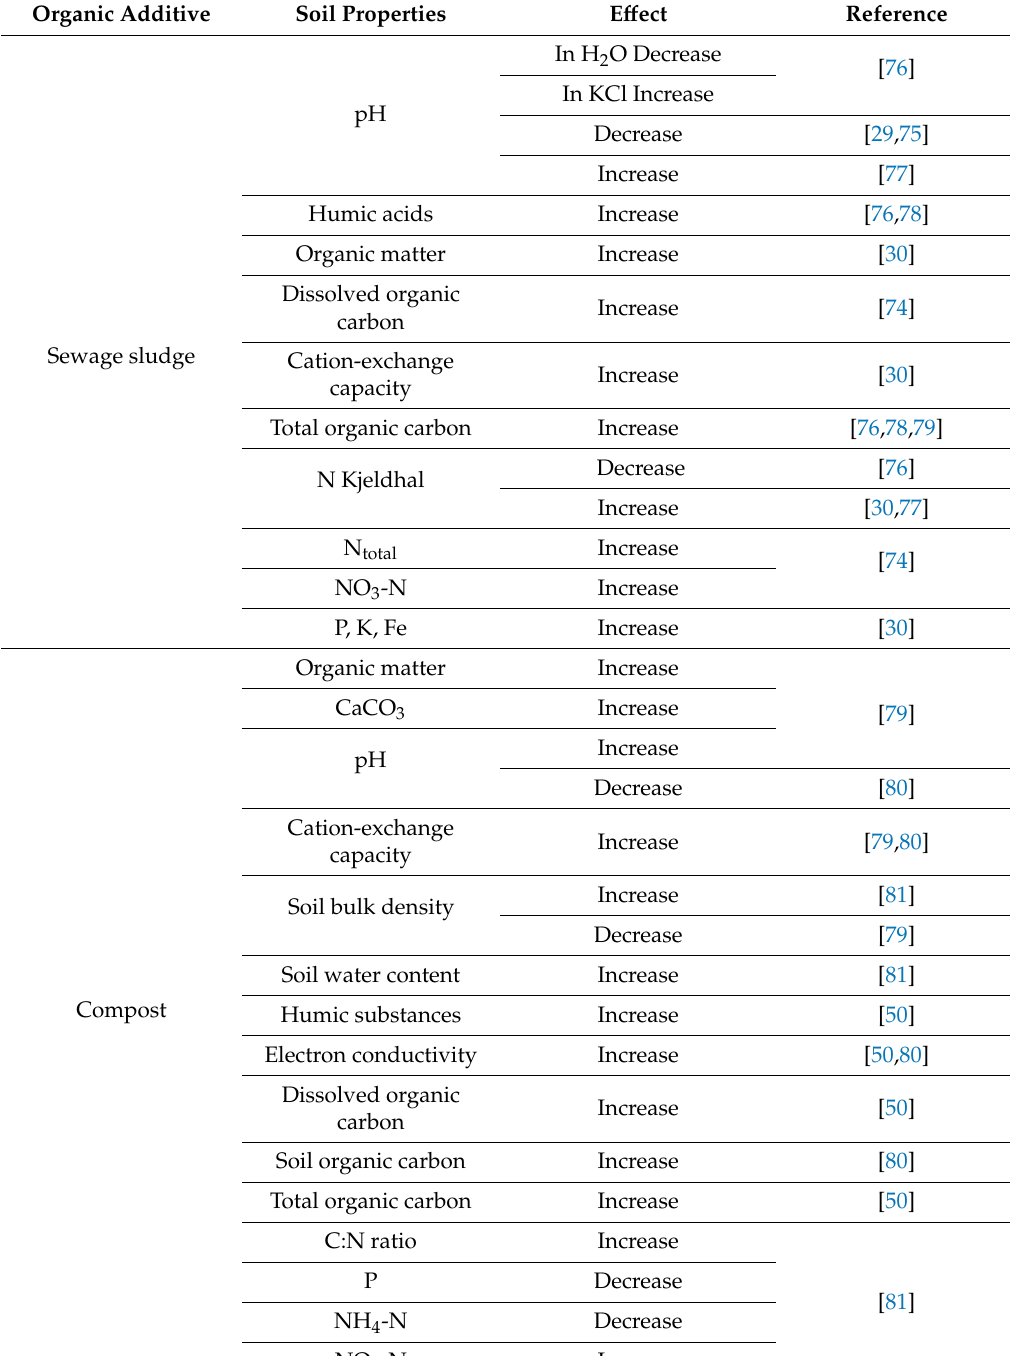
Table 2. Changes in soil properties caused by the application of various biowastes. Organic